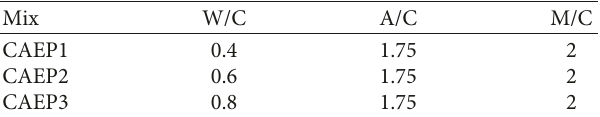
Figure 5: Shear rheology method of CAEP. Table 5: Mix proportions of cement bitumen emulsion pastes for rheology test.